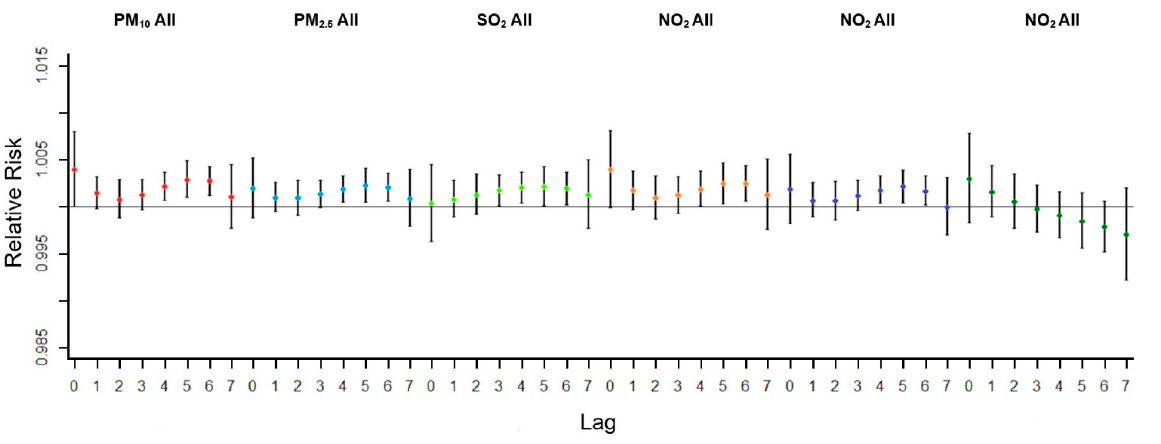
Figure 3. The relative risk of population-wide hospitalization for respiratory disease due to a 10% annual average increase in air pollutant concentration.